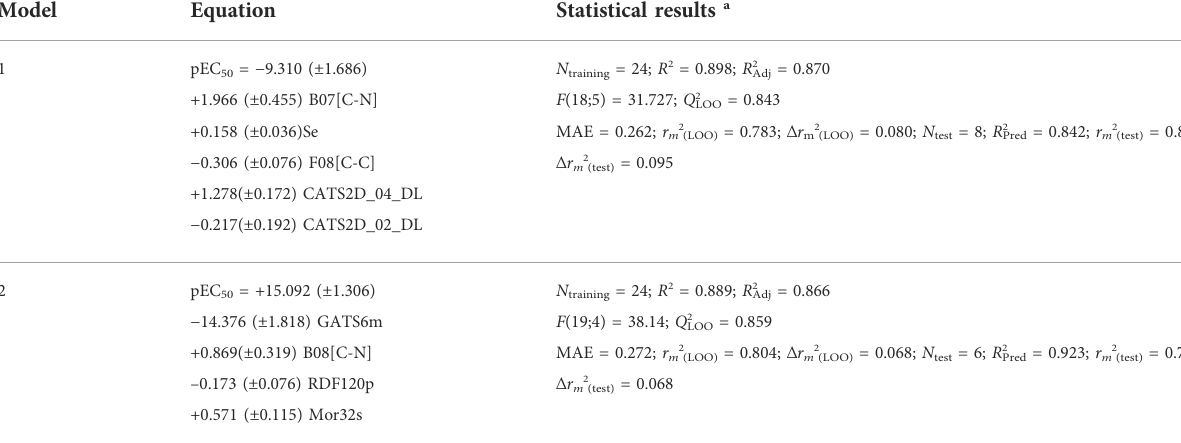
TABLE 2 Equations and statistical results of the fi nal 2D-QSAR models. Model Equation Statistical results